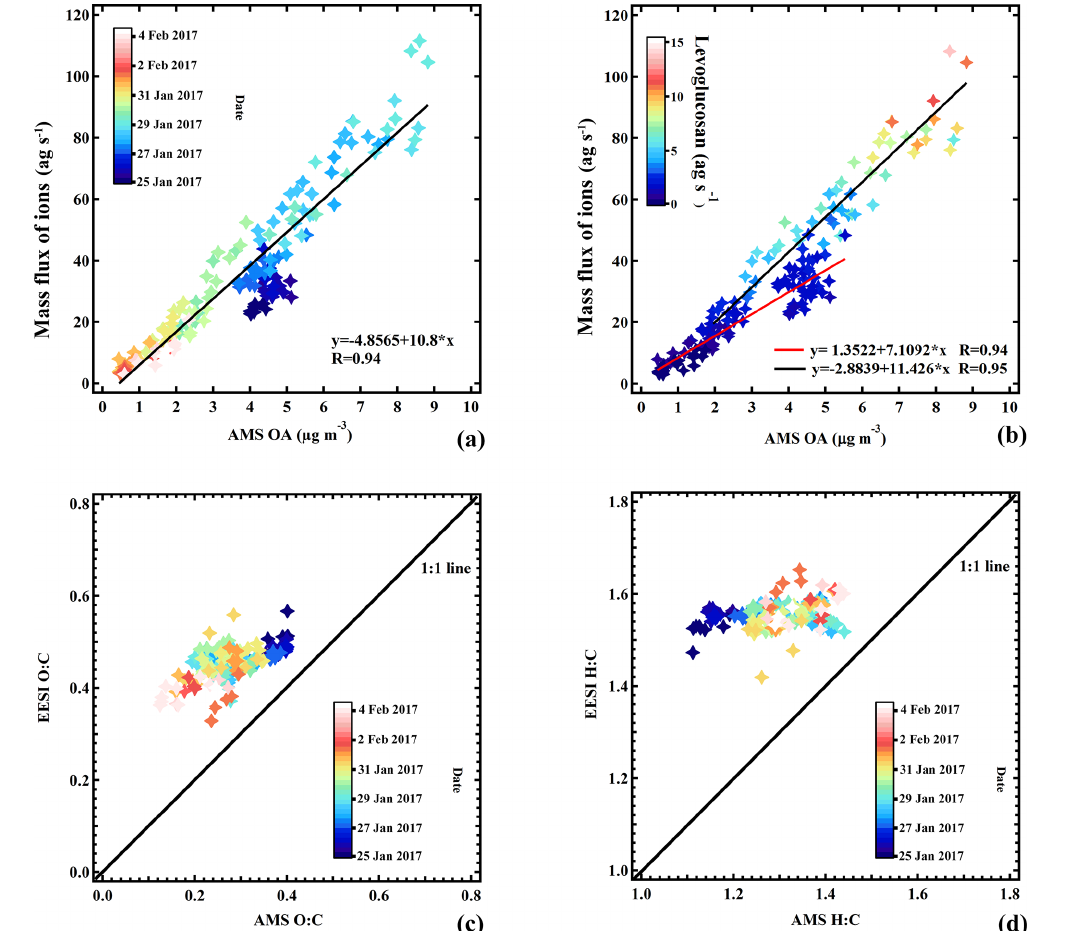
Figure 13. Comparison of EESI-TOF-MS and AMS. Total EESI-TOF-MS mass flux (ags − 1 ) as a function of AMS OA, points are colored by date (a) and the fraction of levoglucosan (b) . The EESI-TOF-MS and AMS comparison in terms of H : C (c) and O : C (d) ; points are colored by